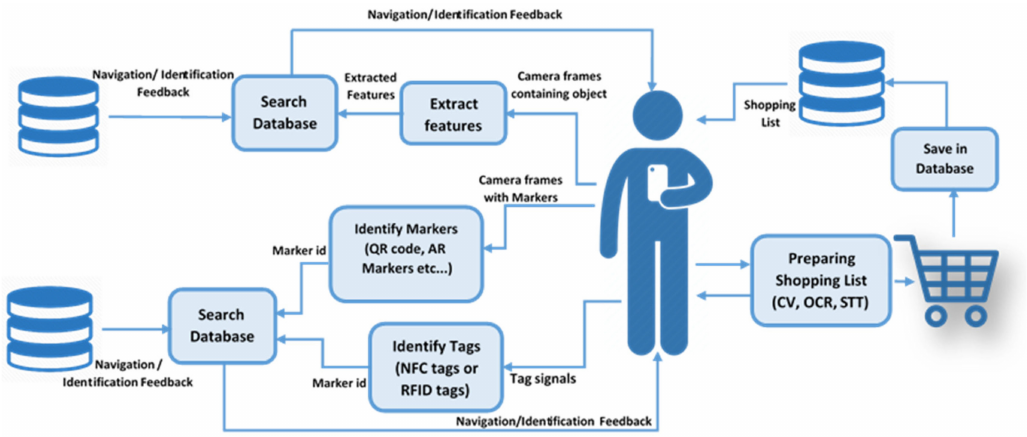
Figure 3. The scenario of the shopping solutions for